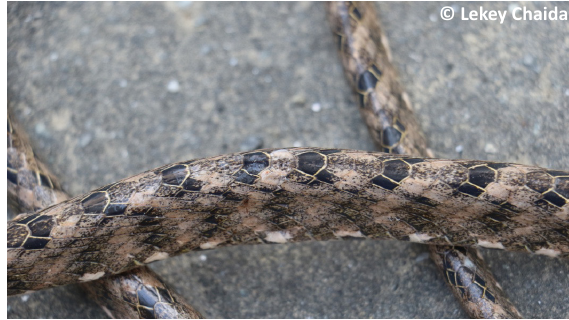
Image 2. Unique arragement of large mid dorsal scales.